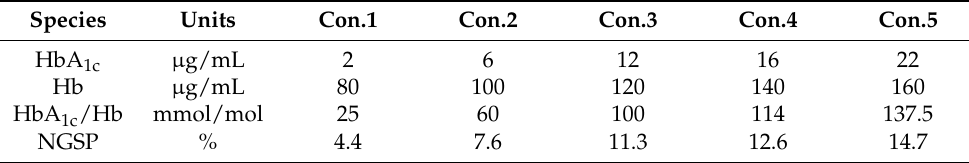
Table 1. Concentration of HbA 1c and Hb, and clinically relevant detection range of HbA 1c and